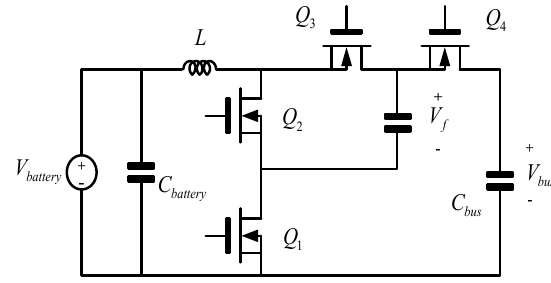
Figure 14. Bi–directional three–level converter [29].